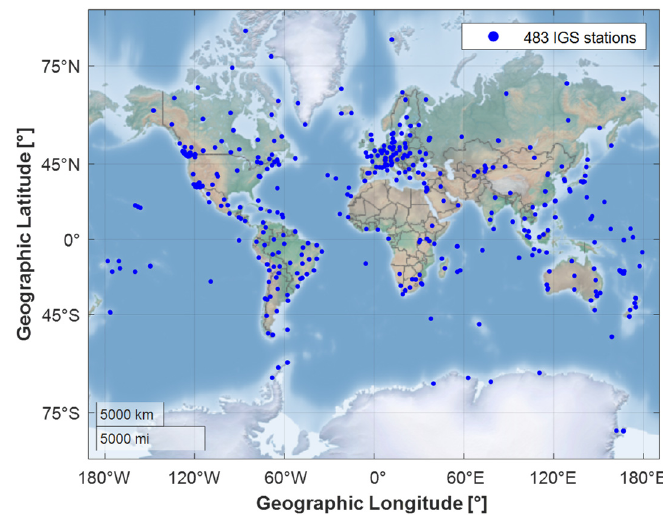
Figure 11. The distribution diagram of all available IGS stations on 26 March 2015 showing the uneven distribution of IGS stations in different regions of the Earth. Here, most of the ocean areas have almost no stations.